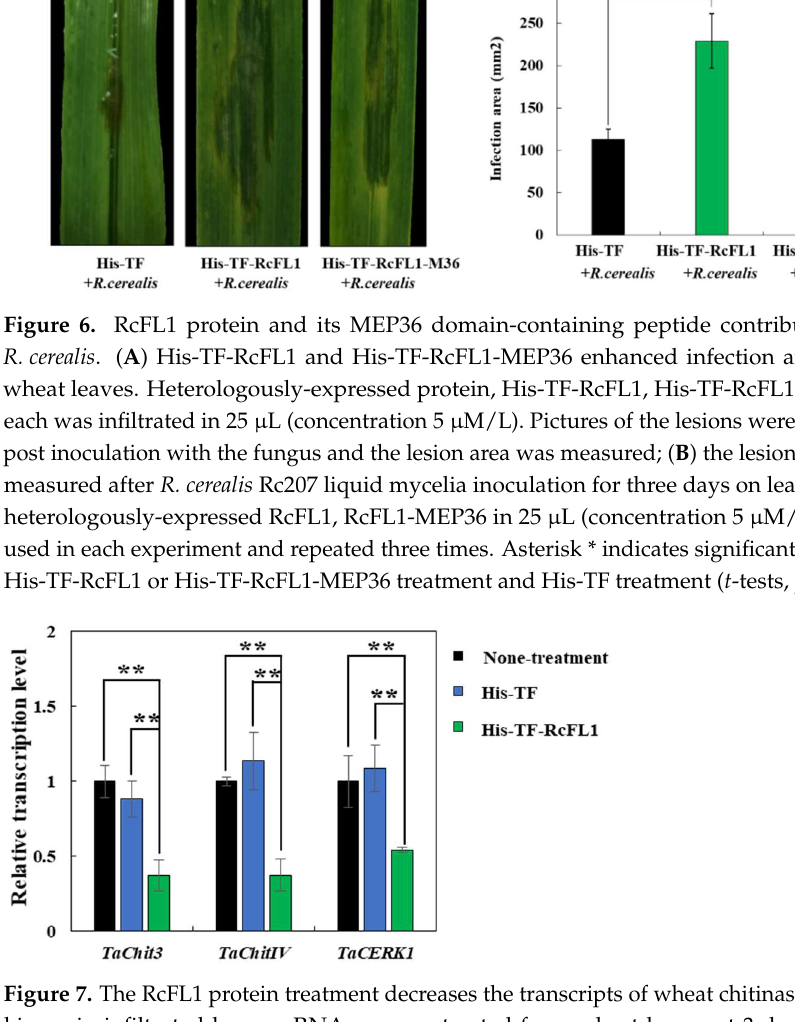
Figure 6. RcFL1 protein and its MEP36 domain-containing peptide contribute to virulence of R. ce- realis . ( A ) His-TF-RcFL1 and His-TF-RcFL1-MEP36 enhanced infection area of R. cerealis in wheat leaves. Heterologously-expressed protein, His-TF-RcFL1, His-TF-RcFL1-MEP36, or His-TF; each was infiltrated in 25 µL (concentration 5 µM/L). Pictures of the lesions were taken at three days post inoculation with the fungus and the lesion area was measured; ( B ) the lesion area/infection was measured after R. cerealis Rc207 liquid mycelia inoculation for three days on leaves infiltrated with heterologously-expressed RcFL1, RcFL1-MEP36 in 25 µL (concentration 5 µM/L). Six leaves were used in each experiment and repeated three times. Asterisk * indicates significant difference between His-TF-RcFL1 or His-TF-RcFL1-MEP36 treatment and His-TF treatment ( t -tests, p < 0.05).